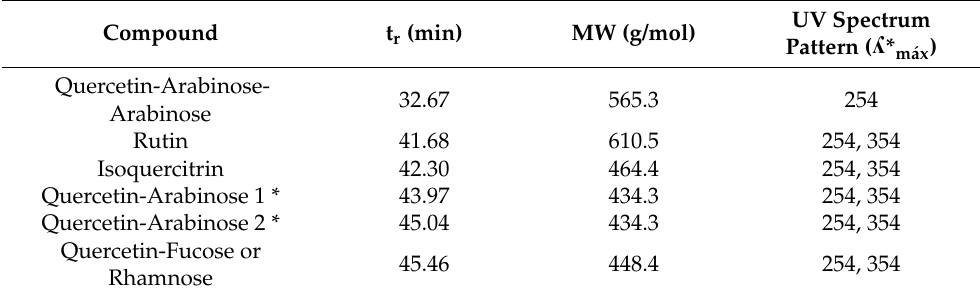
Table 5. List of principal compounds obtained from the apple pomace extraction with ethanol 70% ( v/v ) and 90 °C and their mass spectrometric data.